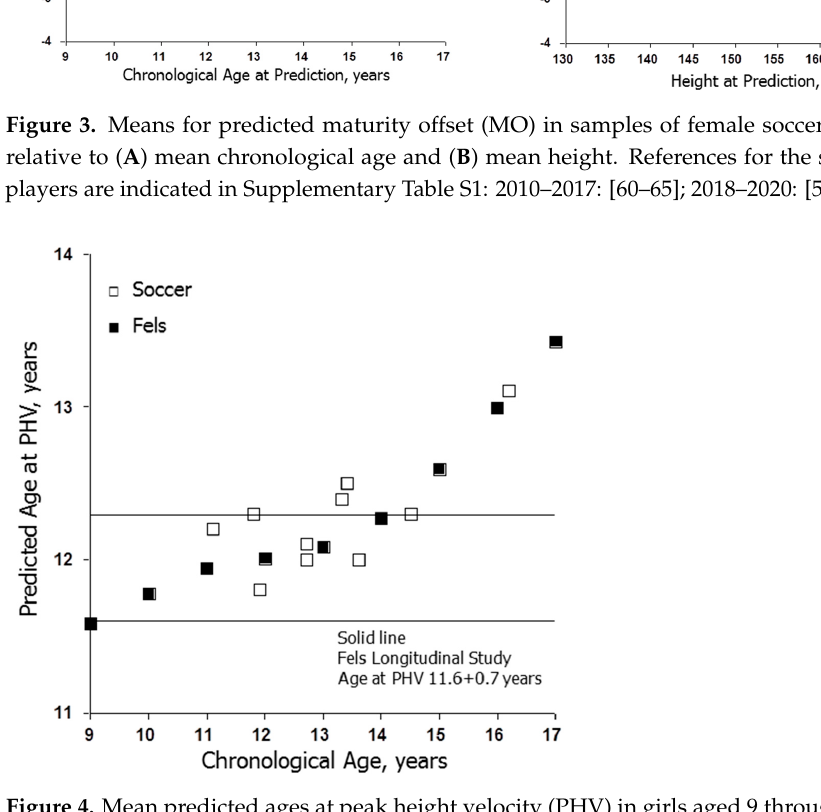
Figure 4. Mean predicted ages at peak height velocity (PHV) in girls aged 9 through 17 years from the Fels Longitudinal Study [57] and for female soccer players. The solid lines indicate the mean plus one standard deviation for observed age at PHV in the Fels Longitudinal Study. References for studies of soccer players are indicated in Supplementary Table S1: 2010–2017: [60]; 2018–2020: [59,64,66]; the means were calculated for select and non-select players combined in each CA group for reference